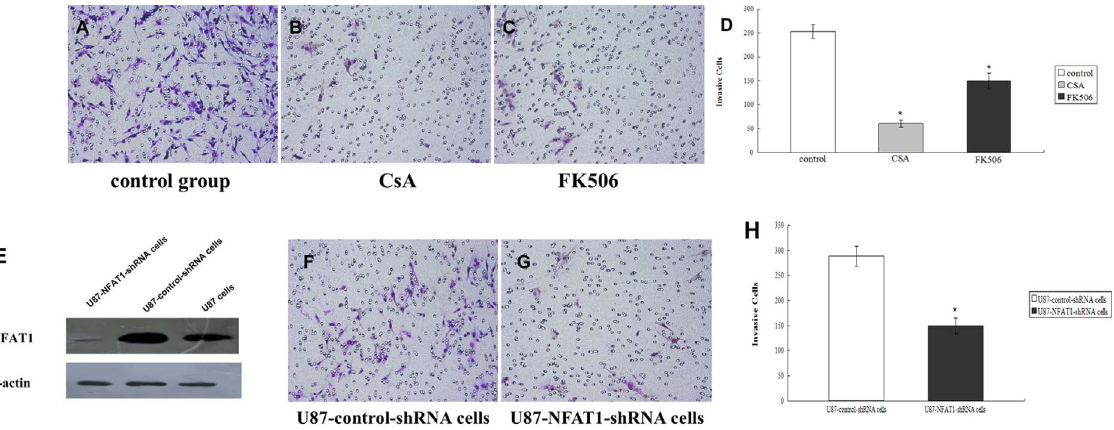
Figure 3. Effect of NFAT1 inhibition on invasion of GBM U87 cells. U87 cells were untreated or treated with CsA or FK506. The microscopic image of the invasive cells is shown to the left (A, B and C). The mean values from duplicate samples of three independent experiments are shown to the right (D). E: Western blot analysis was used to examine the expression of NFAT1 in U87, U87-control-shRNA and U87-NFAT1-shRNA cells. NFAT1 expression was stably knocked down in U87-NFAT1-shRNA cells. (F-H) Effect of NFAT1 down-regulation on invasion of GBM U87 cells. The microscopic image of the invasive cells is shown to the left (F and G). The mean values from duplicate samples of three independent experiments are shown to the right (H). *, P , 0.05.